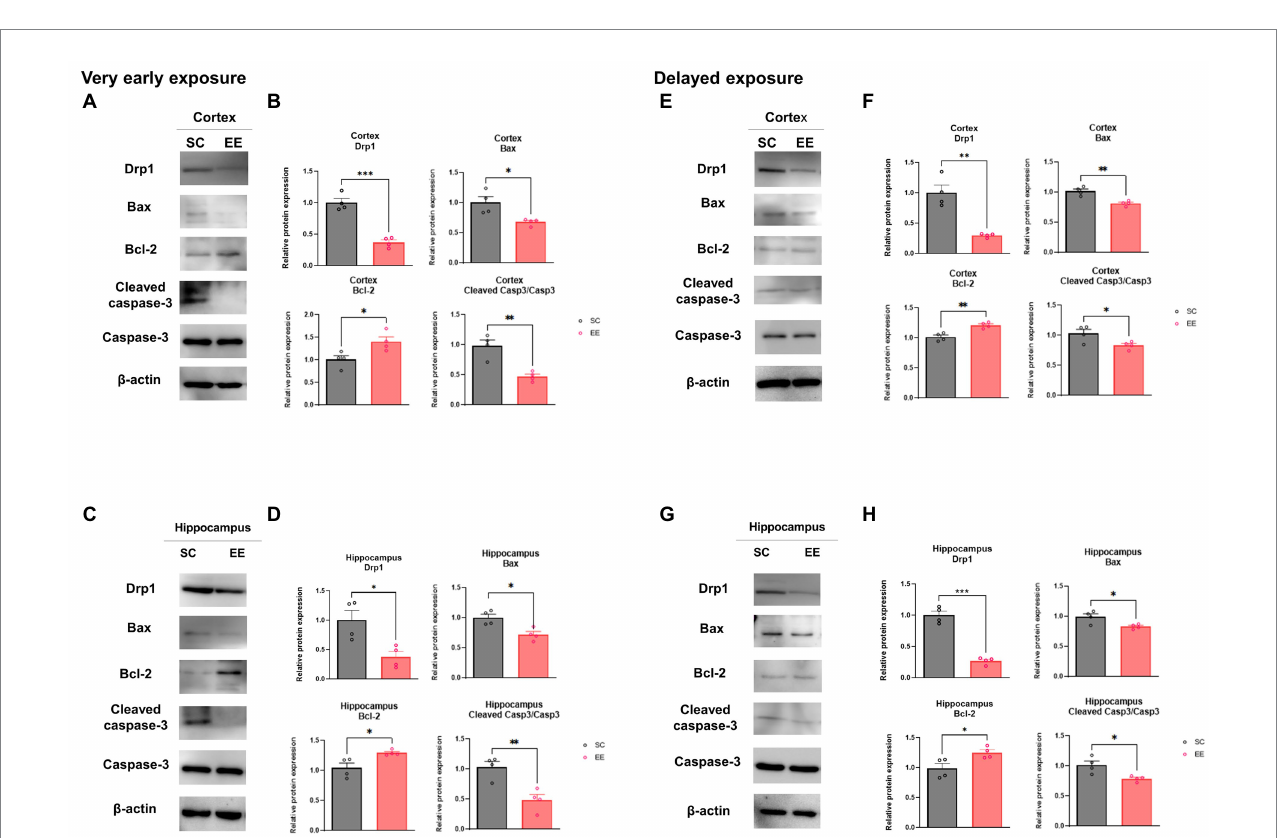
FIGURE 4 Effects of very early and delayed exposure to EE on the expression of mediators of mitochondrial dynamics and intrinsic apoptosis-related proteins in the cerebral cortex and the hippocampus. Representative WB images of the cerebral cortex (A) and the hippocampus (C) after very early exposure to EE. (B,D) Quantification of Drp1, Bax, Bacl-2, and cleaved Caspase-3 levels in the cerebral cortex (B) and the hippocampus (D) ( n = 4 per group). (E,G) Representative WB images of the cerebral cortex (E) and the hippocampus (G) after delayed exposure to EE (F,H) Quantification of Drp1, Bax, Bacl-2, and cleaved Caspase-3/Caspase-3 levels in the cerebral cortex (B) and the hippocampus (D) ( n = 4 per group). All statistical comparisons were performed via Student’s t-tests. Data represented are means ± SEM. * p < 0.05, ** p < 0.01, and *** p < 0.001. EE, environmental enrichment; WB, western blot.